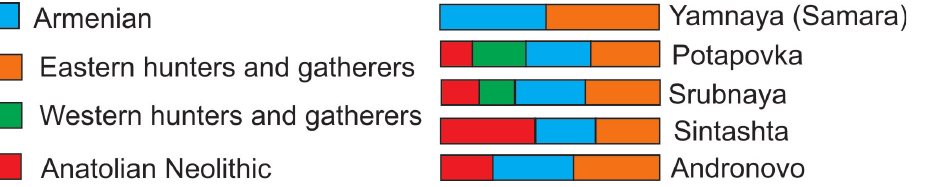
Figure 20: Genetic composition of the Early Bronze Age and Middle Bronze Age populations of Eurasia (after Mathieson et al., 2015, Extended Data, Fig.